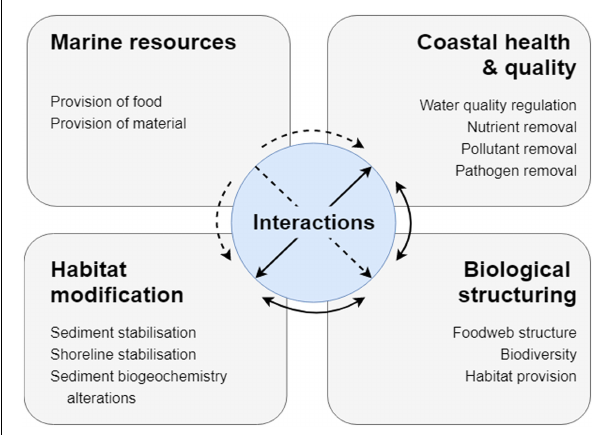
FIGURE 2 | Bundles of ecosystem services provided by shellfish. Each box contains the services grouped for the respective bundles. Arrows between bundles in the center of the figure indicate the interactions between bundles either as synergies (black bi-directional arrows) or trade-offs (dashed one-directional